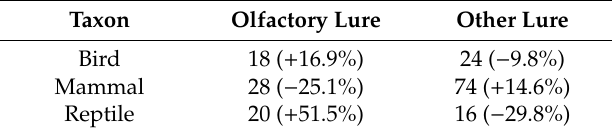
Table 5. The number of individuals captured at Francois Peron National Park from each taxon when di ff erent lure types were used. Percentage deviations (a measure of the extent to which the observed chi-square value varies from that expected if there is no association between the variables) are shown for each result.